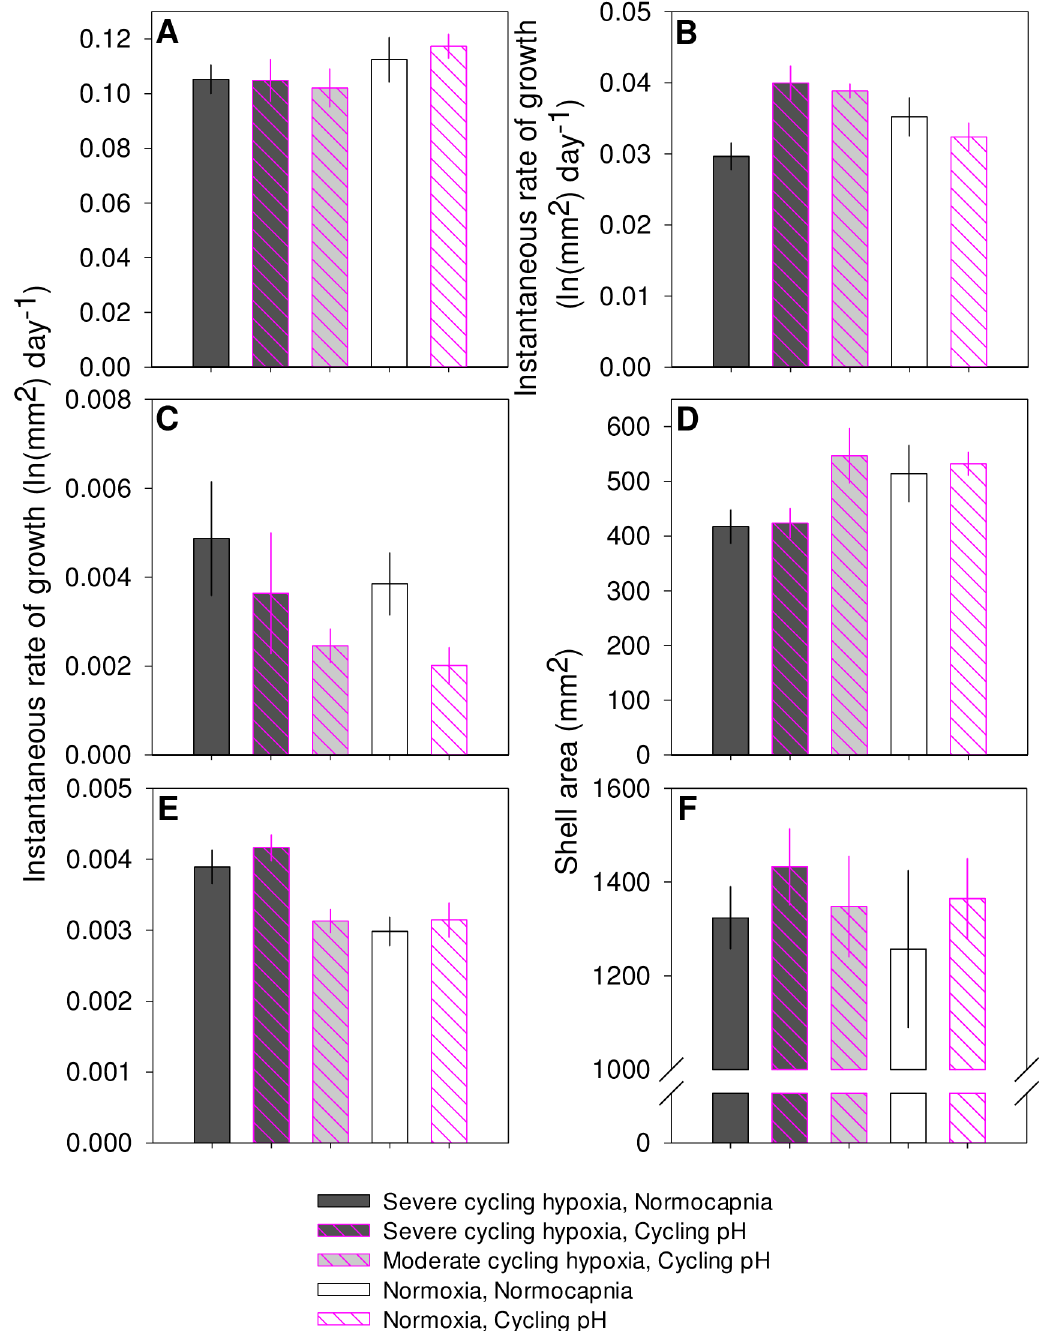
Fig 2. 2012 juvenile growth experiment. Mean ± SE instantaneous rate of growth in area by treatment of juvenile oysters exposed to diel cycles 4 – 5 d wk -1 during (A) the first two weeks, (B) second two weeks, and (C) weeks four- seven. (D) shell area at the conclusion of the laboratory growth experiment. (E) instantaneous rate of growth during a 9-month field deployment and (F) shell area at the conclusion of the 9-month field